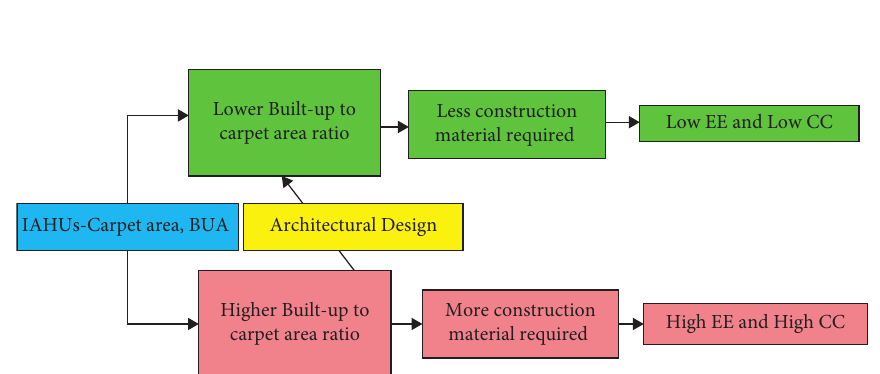
Figure 3: Interrelation of the construction area, built-up area-to-carpet area ratio, construction cost, and embodied energy. Table 2: Carpet area, built-up area, and built-up-to-carpet area ratio for selected 30